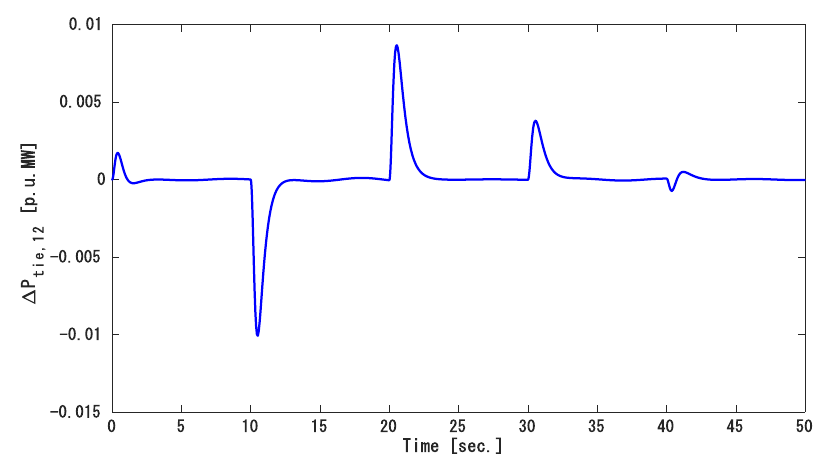
Figure 10. Tie-line power variation.